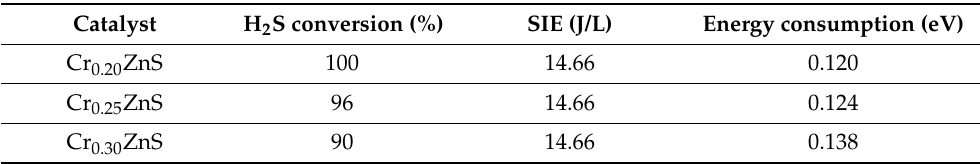
Table 3. Conversion efficiency, specific input energy, and energy consumption for catalytic hydro- gen